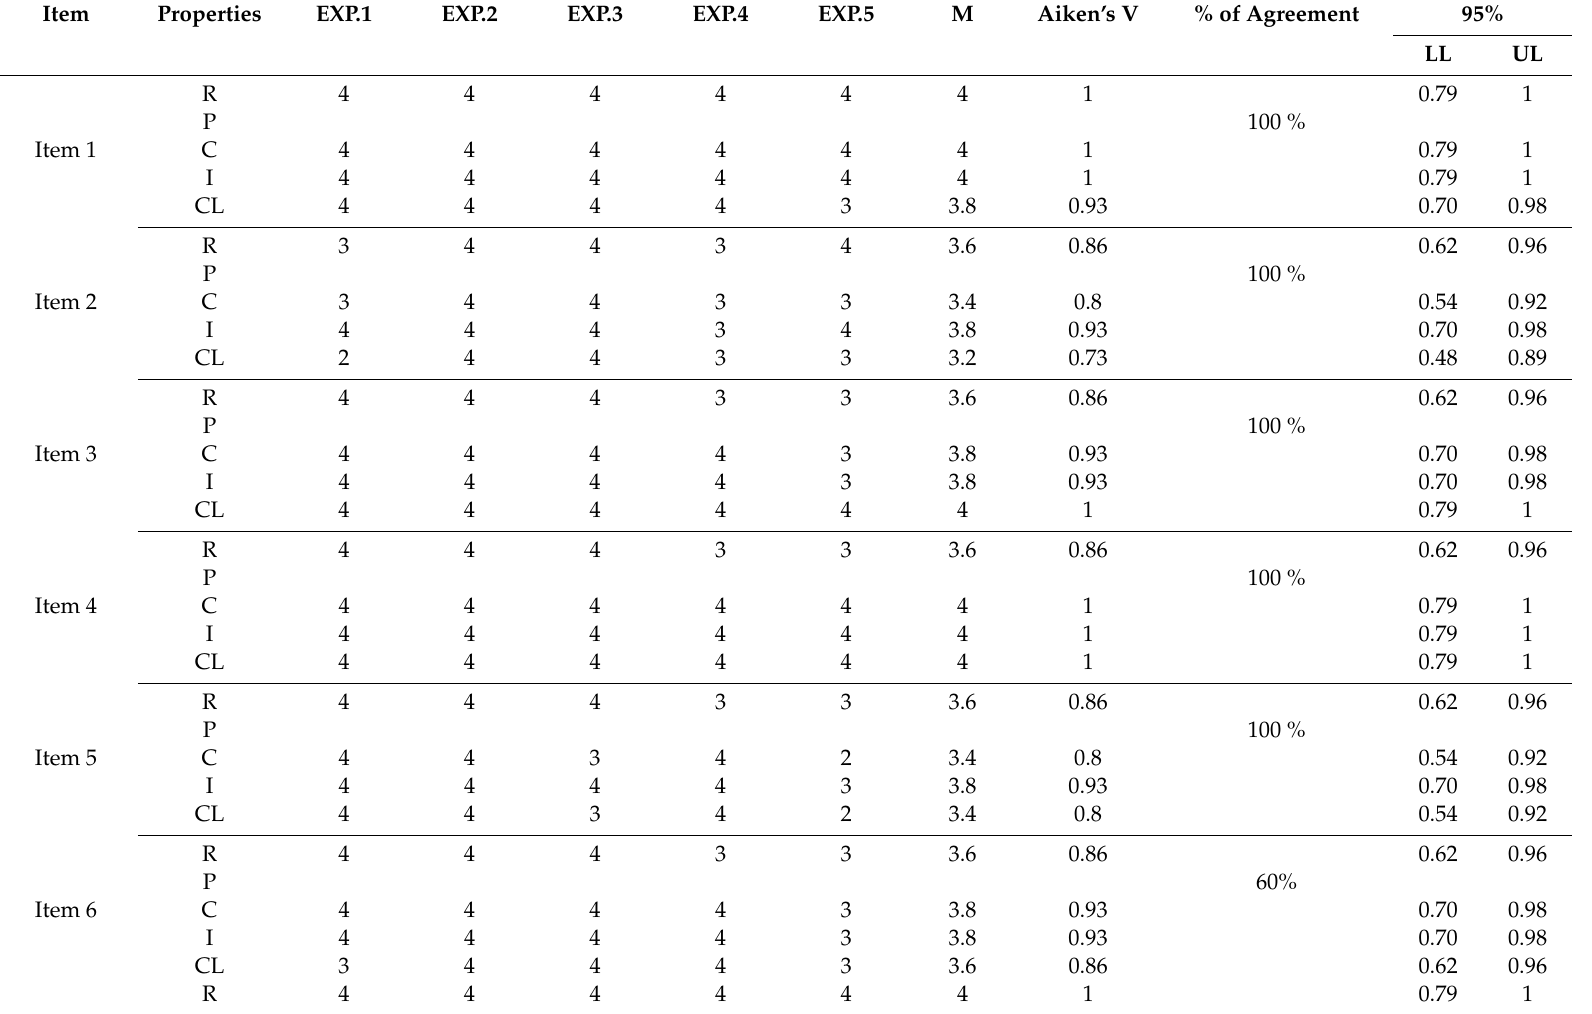
Table 2. Assessment by experts of items included in the scale of attitudes toward HIV / AIDS among